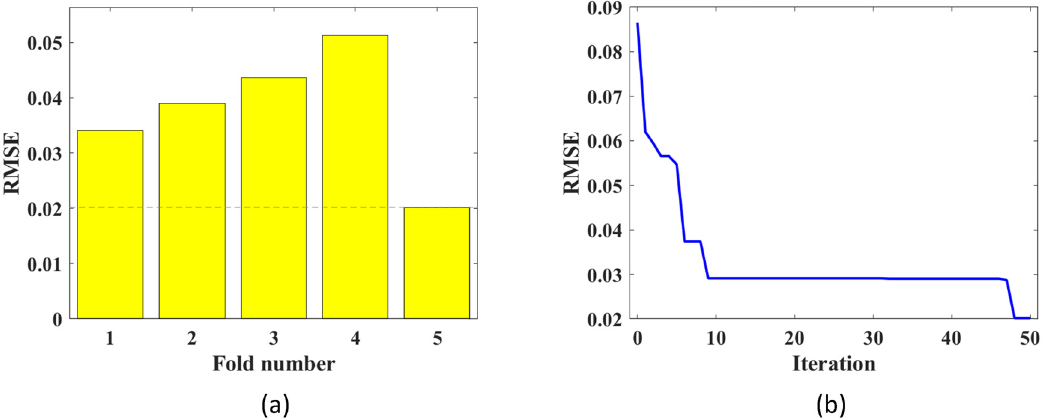
Figure 15: The CV results of equivalent damping coe ffi cient prediction and the optimal fold iterative process. ( a ) 5 - fold CV results. ( b ) The iterative process of optimal